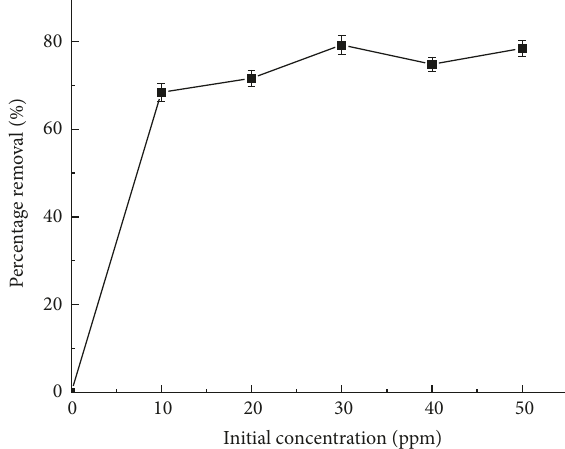
Figure 8: Langmuir isotherm of Cr(VI) adsorption using hybrid membrane of carboxymethyl chitosan and silicon dioxide.